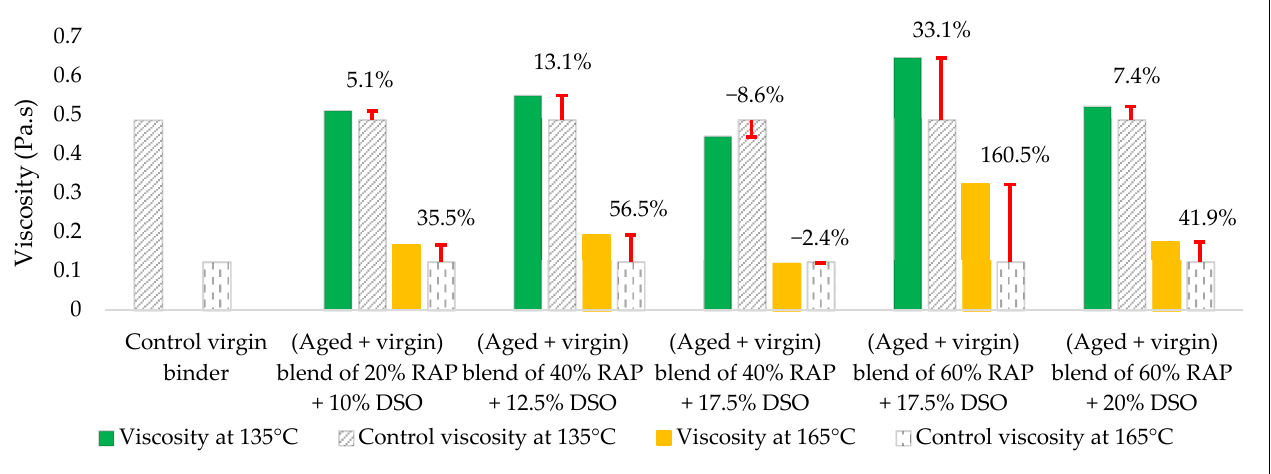
Figure 19. The change in viscosity level from adding DSO as a rejuvenator to the combined blend of binders in comparison to the control viscosity of the virgin binder.